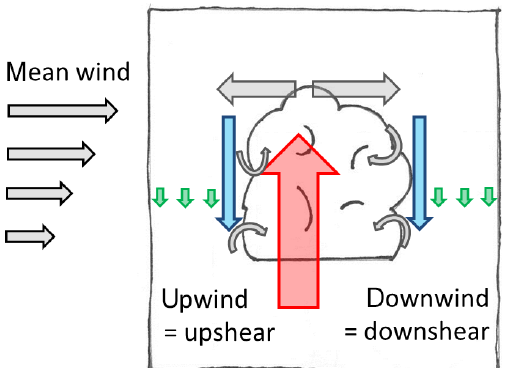
Figure 1. Conceptual model of a small cumulus cloud. The verti- cal mass flux within the cloud (red arrow) is compensated either through large-scale subsidence (green arrows) or in the subsiding shell (blue arrows). Grey arrows indicate detrainment above the cloud and entrainment on the lateral cloud boundaries. The main updraught is shifted towards the upshear cloud boundary.